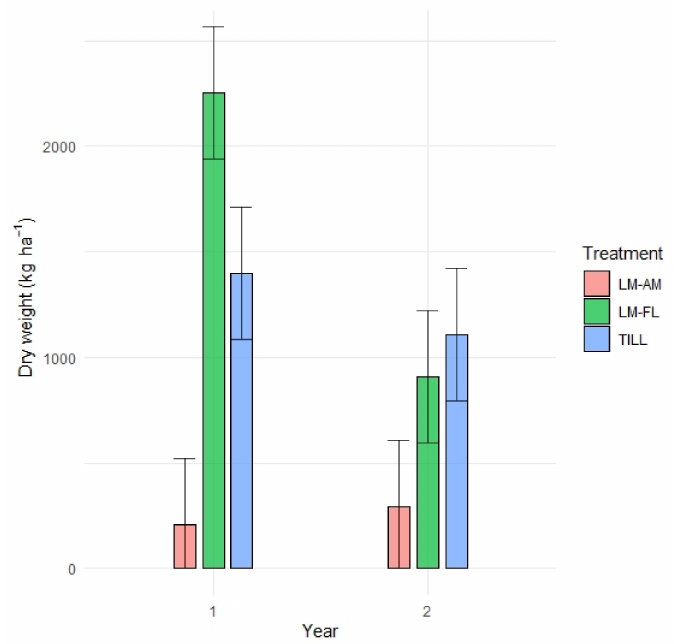
Figure 7. Effect of treatments (TILL, LM-FL, LM-AM) and years (1 is 2020, 2 is 2021) on the dry weight of the total aboveground biomass of weeds collected in eggplants at harvest time. Error bar represents the upper and lower limits of the 95% confidence interval.